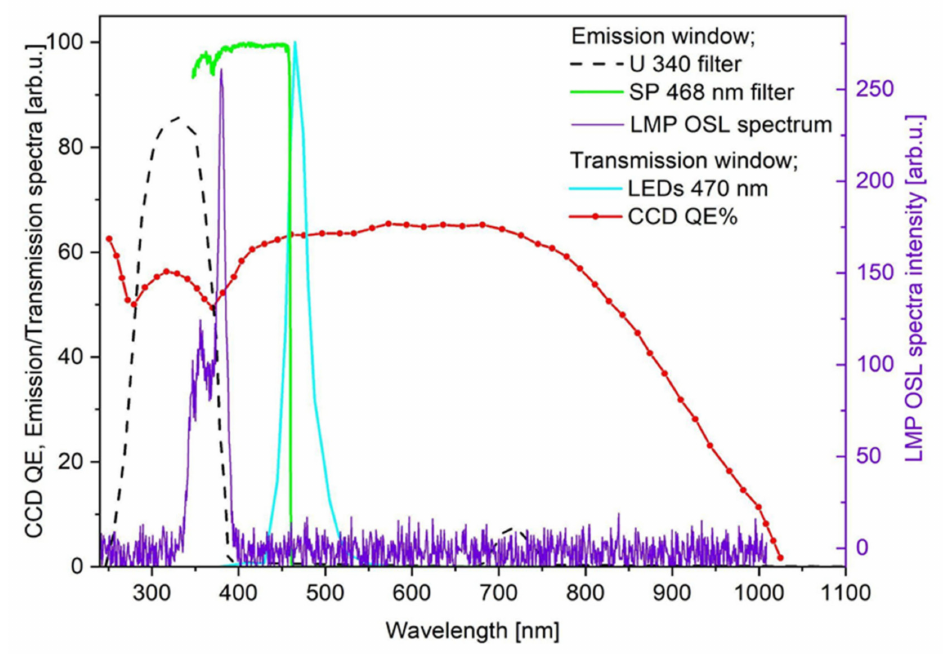
Figure 8. Comparison between the CCD camera quantum efficiency, the LEDs emission spectra (470 nm) and the 468/SP + U340 filters transmissions (all data left hand scale). The measured OSL emission spectra of the LMP material (irradiated with 90 Sr/ 90 Y beta particles), extends from 330 nm to 400 nm, with a maximum two peaks at 355 nm and 380 nm (right hand